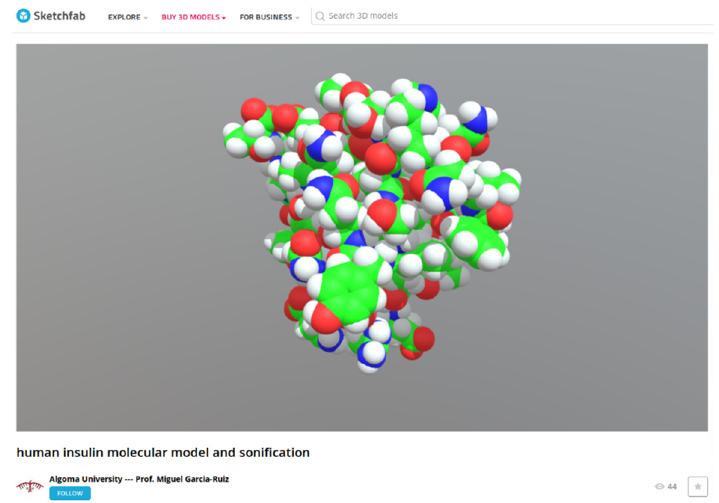
Figure 5. The molecular model of insulin shown on the Sketchfab Table 1. Mappings among amino acids’ hydrophobicity [64] and musical instruments.